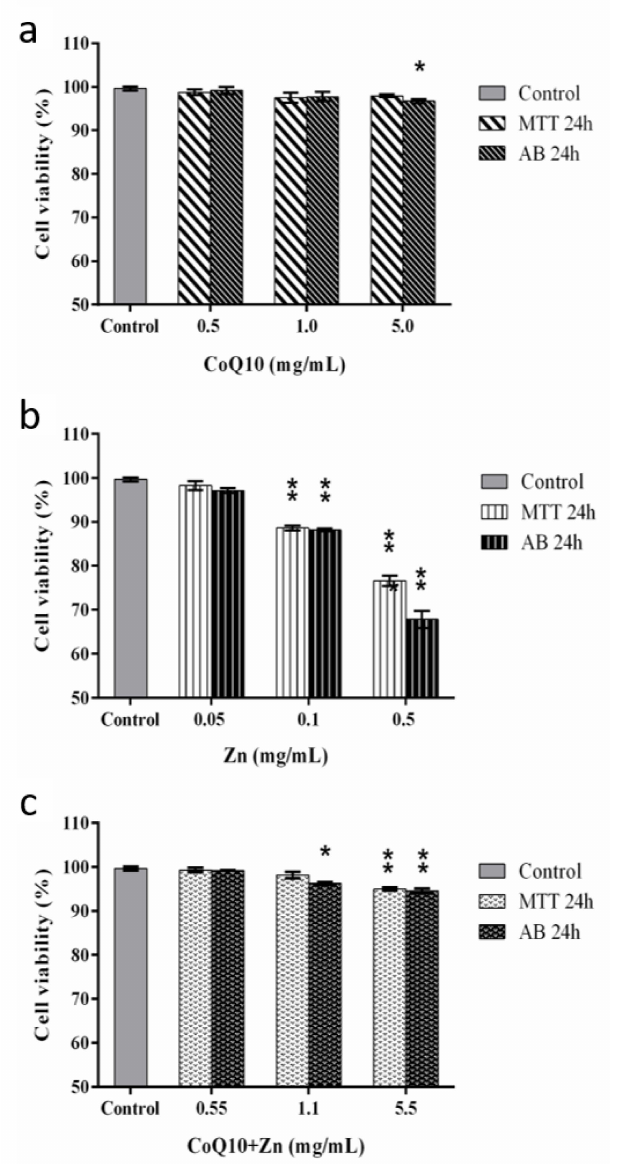
Figure 8. Cell viability by the MTT and Alamar Blue ® methods after 24 h of exposure in CHOK-1 cells treated with CoQ10 ( a ), Zn ( b ) and CoQ10 + Zn ( c ) in different concentrations. Statistical analysis was performed by one-way ANOVA test, followed by Tukey’s post-hoc test. The p -values are represented by * ( p = 0.02–0.009) and ** ( p ≤